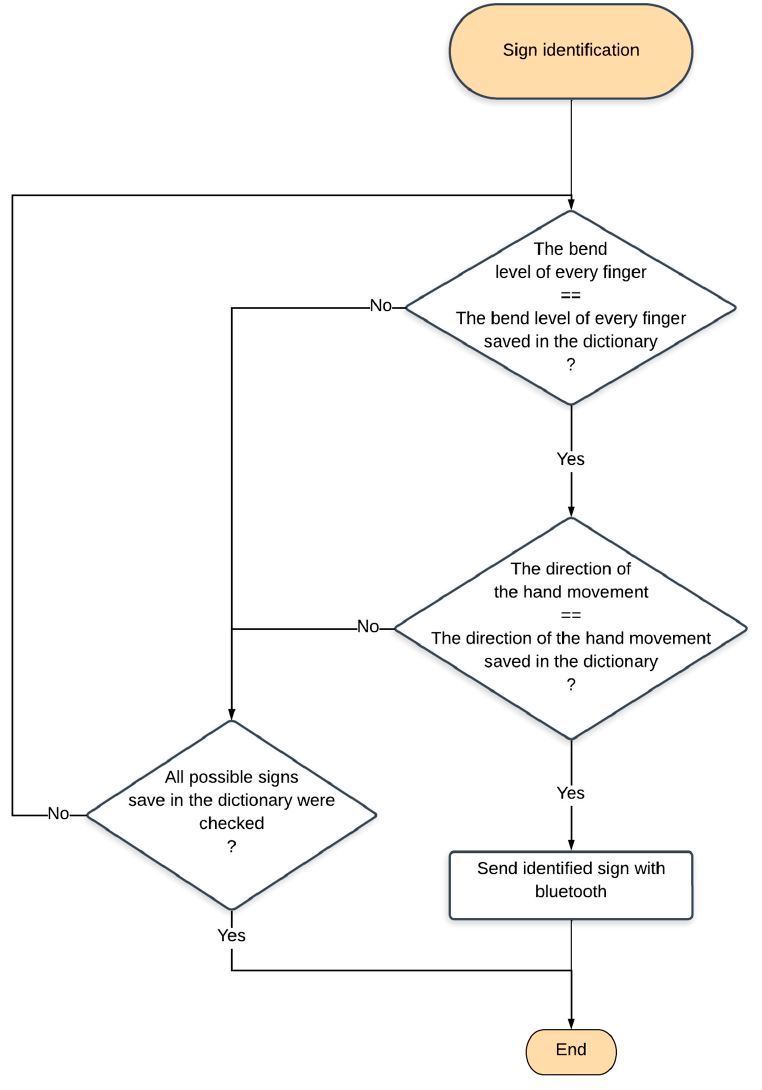
Figure 6. Sign identification algorithm. Table 1. Combinations of parameters that must be satisfied for every letter. Max—finger bent maximally; Mid—finger slightly bent; Min—straight finger. The accelerometer column shows whether usage of the accelerometer is necessary for the finger. Blue color indicates the letters that are not easily identified (more in Section 4,